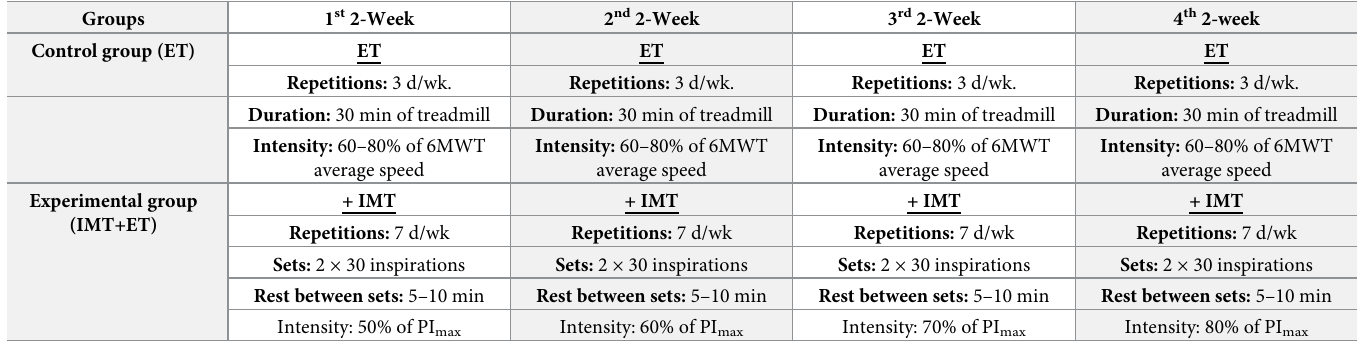
Table 1. Design of training program.